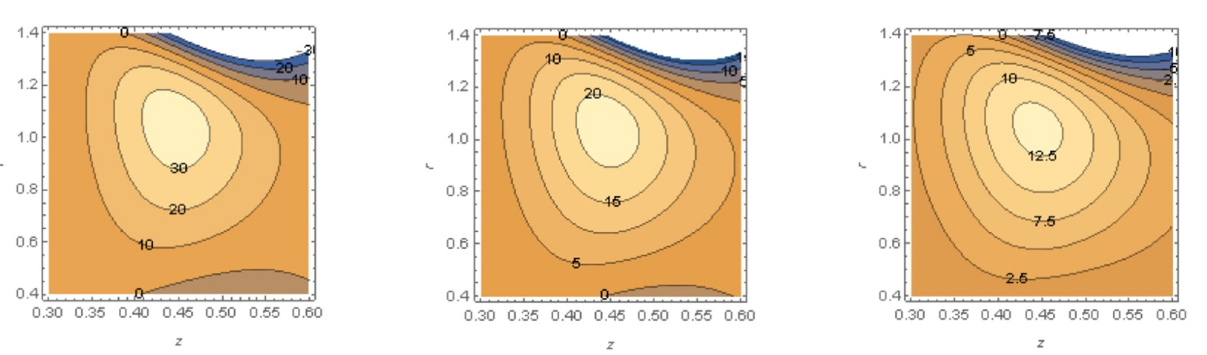
Figure 25: Various values of the wave frame streamlines of n = { 0.3, 0.5, 0.7 } at